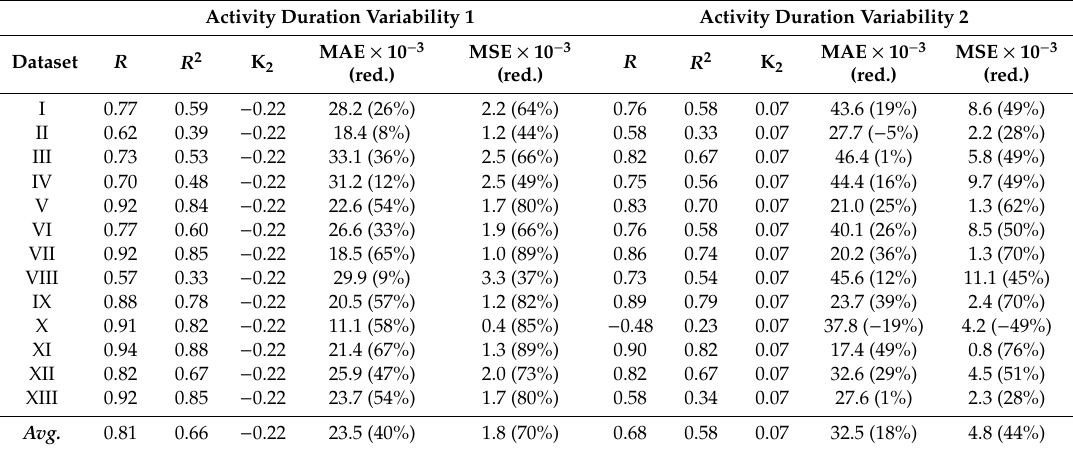
Table 4. Project duration standard deviation estimates ( σ p / σ K ) performance results for the 13 project